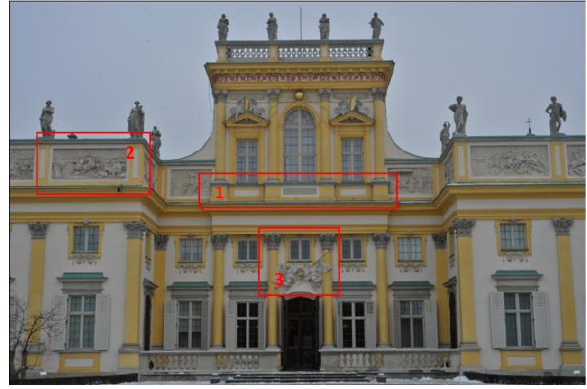
Figure 7. The scheme of test field localization used for camera calibration accuracy